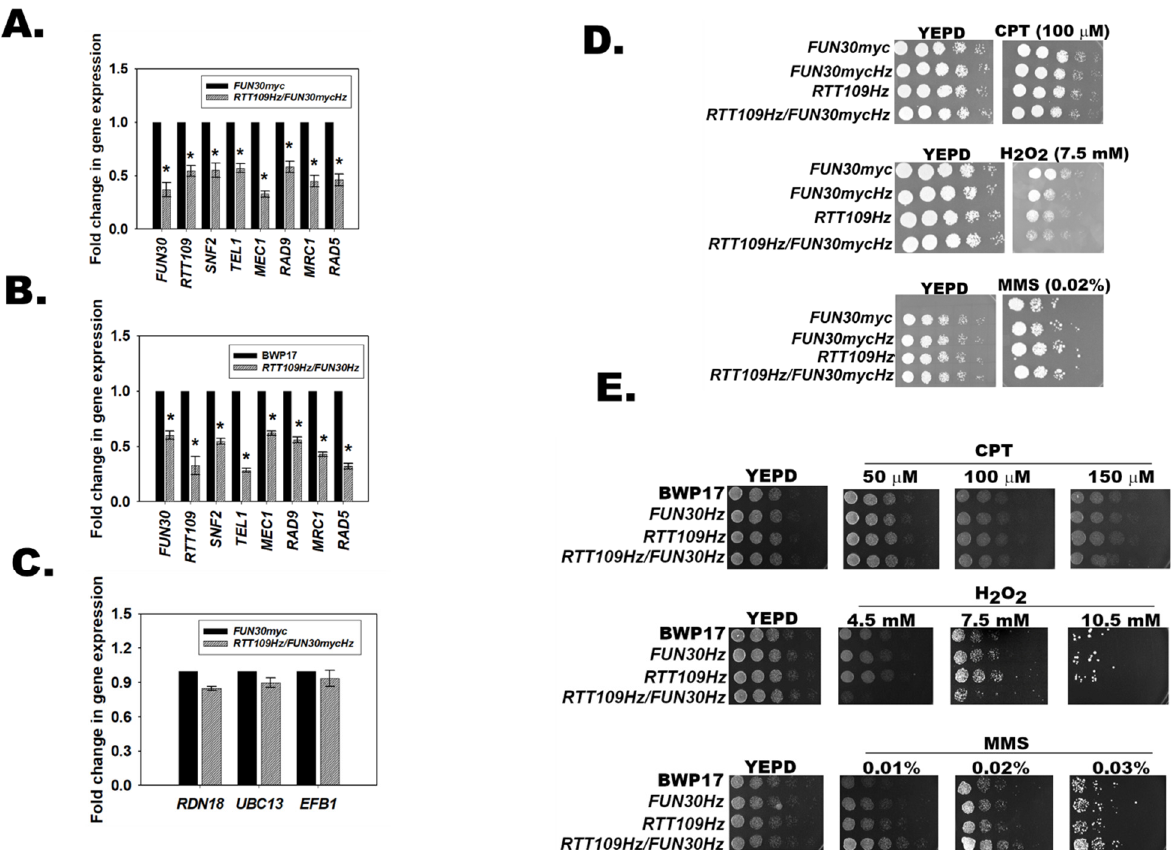
Figure 5. RTT109Hz / FUN30Hz double mutant shows a differential response to genotoxic stress. ( A ). Expression of FUN30 , RTT109 , SNF2 , TEL1 , MEC1 , RAD9 , MRC1 , and RAD5 was evaluated in FUN30myc and RTT109Hz/FUN30mycHz strains using qPCR. ( B ). Expression of FUN30 , RTT109 , SNF2 , TEL1 , MEC1 , RAD9 , MRC1 , and RAD5 was evaluated in BWP17 and RTT109Hz/FUN30Hz strains using qPCR. ( C ). Expression of RDN18 , UBC13 , and EFB1 was analyzed by qPCR in RTT109Hz / FUN30mycHz strain. ( D ). Sensitivity of FUN30myc , RTT109Hz , FUN30Hz , and RTT109Hz/FUN30mycHz strains was studied in the presence of CPT (100 µM), H 2 O 2 (7.5 mM), and MMS (0.02%). ( E ). Sensitivity of BWP17, RTT109Hz , FUN30Hz , and RTT109Hz/FUN30Hz strains was studied in the presence of CPT, H 2 O 2 , and MMS. The qPCR data are presented as average ± s.e.m.